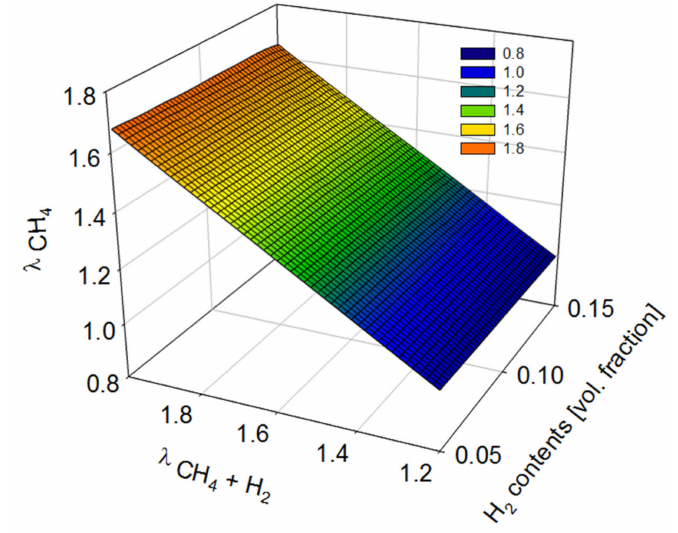
Figure 4. Relationship between total excess air ratio and excess air ratio of CH 4 when considering hydrogen content.